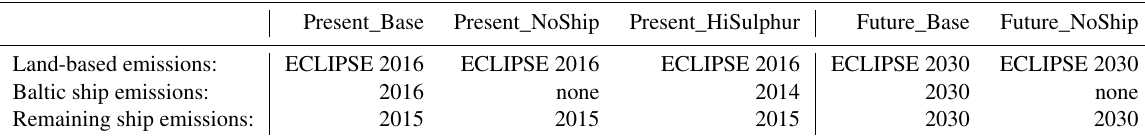
Table 1. All model scenarios have been calculated for the 3 meteorological years 2014, 2015, and 2016. In the comparisons to measurements in Table 2 only year 2016 model calculations are shown. The land-based ECLIPSE emissions for 2016 have been interpolated between 2015 and 2020. SECA regulations for the North Sea are included in the remaining sea ship emissions. The 2020 sulfur cap is included in the 2030 ship emissions outside the SECAS.